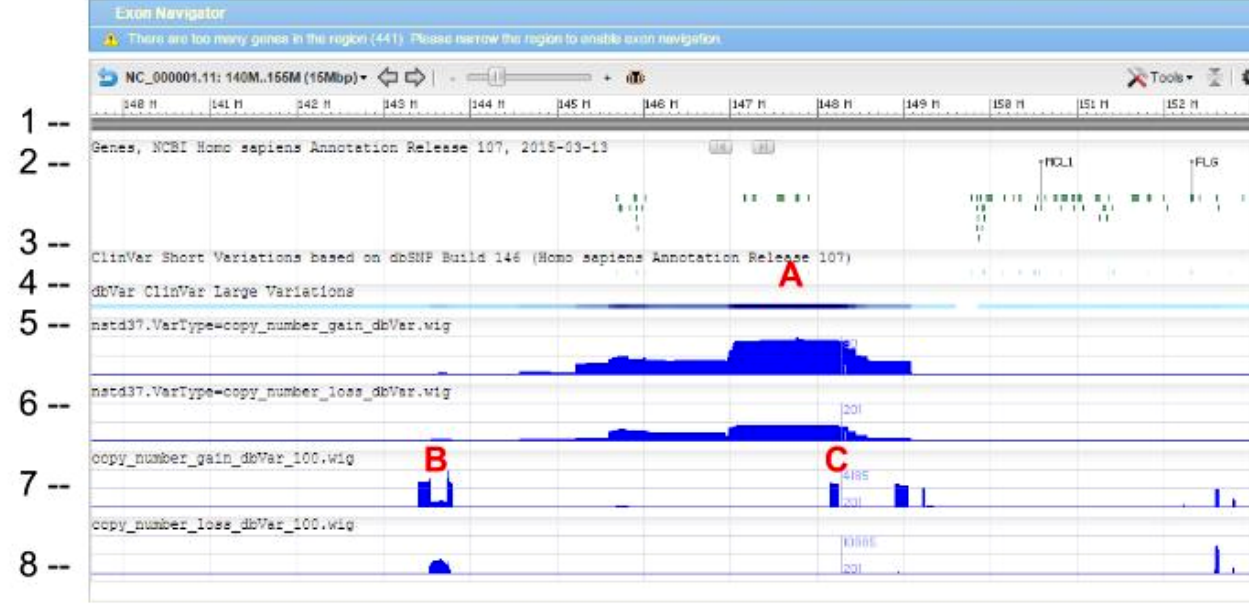
Figure 4. Zoomed in view of the red box region in Figure 1 showing dbVar:nstd37 SVC peak A corresponding to ClinVar variants and flanking peaks B and C from the common combined-set. The track and histogram scales are as described in Figure 5.